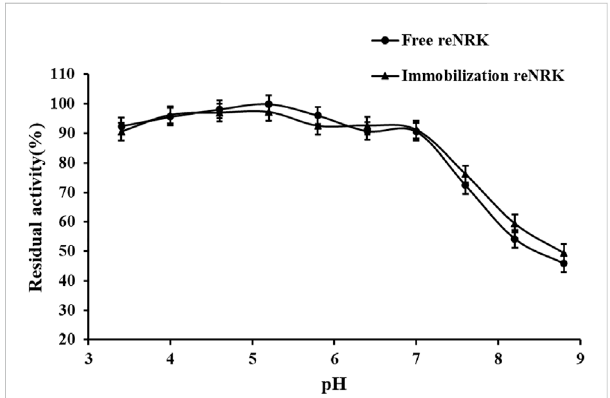
FIGURE 8 The pH stability of the re Sc NRK1. The residual activities